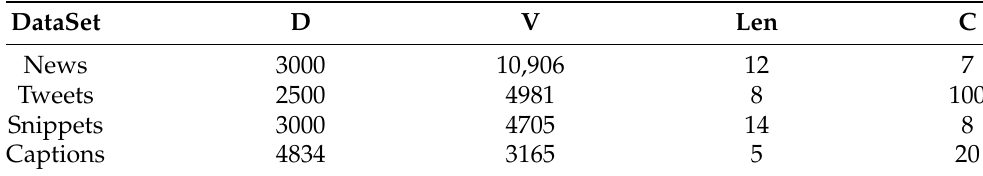
Table 2. Statistics of short texts